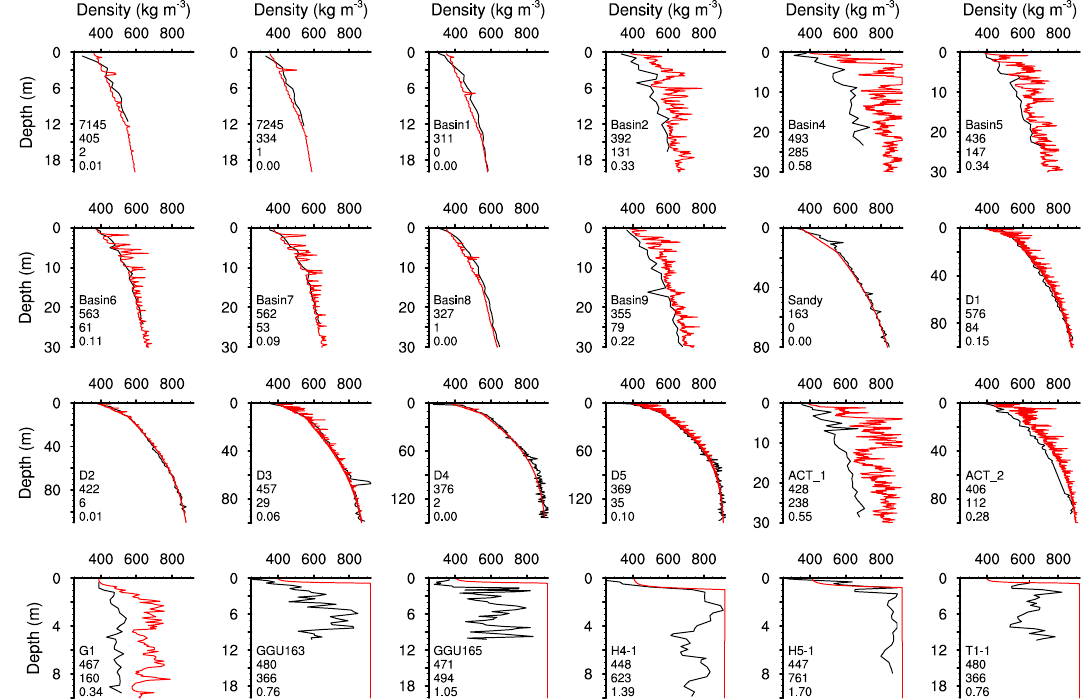
Figure 3. Observed (black) and modelled (red) firn density profiles for 24 of the 62 firn cores on the Greenland Ice Sheet. The four lines of text in each panel show (1) the core name, (2) mean annual accumulation and (3) melt (in mmw.e.yr − 1 ) from RACMO2.3, and (4) the ratio of these fluxes ( R ma , dimensionless). Remaining profiles are shown in Appendix A as Figs. A1 and A2.